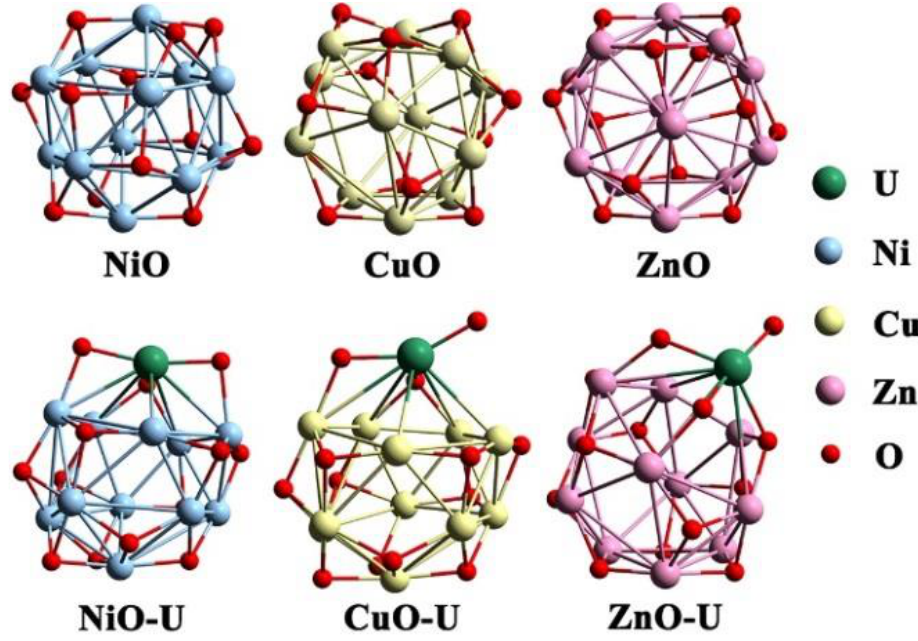
Figure 1. Optimized structures of transition metal oxide catalysts and uranium-doped ones.